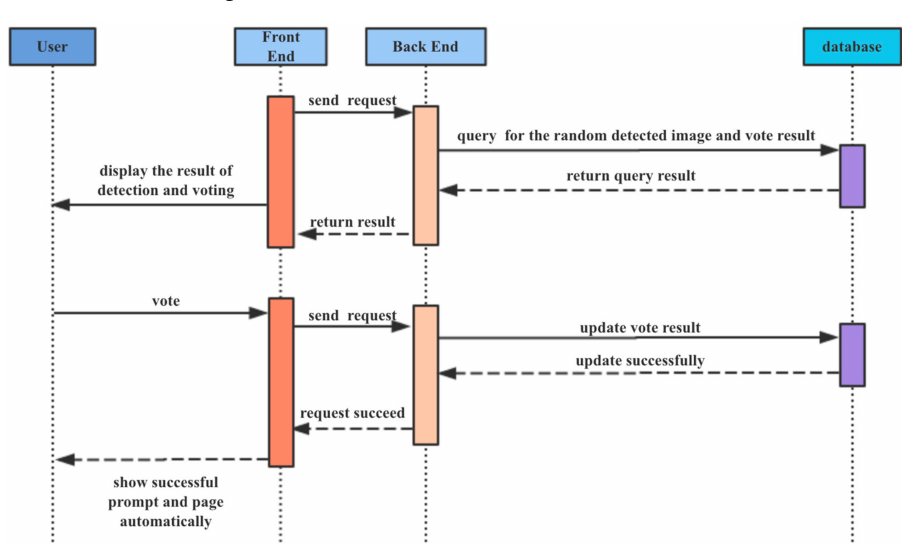
Figure 15. The data flow of the manual review